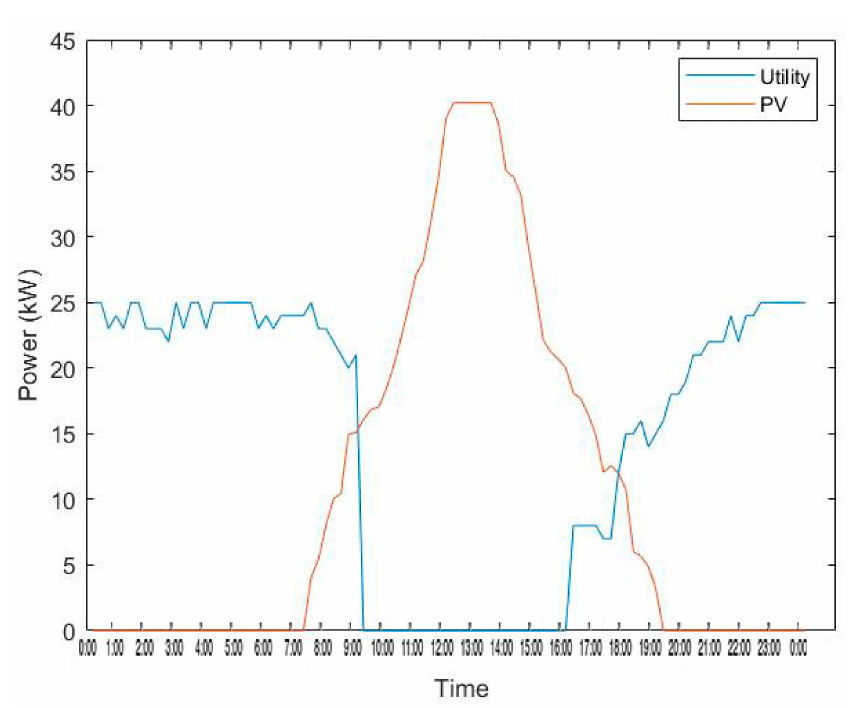
Figure 8. Utility grid power supply and PV in Faulty Grid (FG). Table 3. Utility grid power supply and PV street generation in Case 2 (Faulty Grid